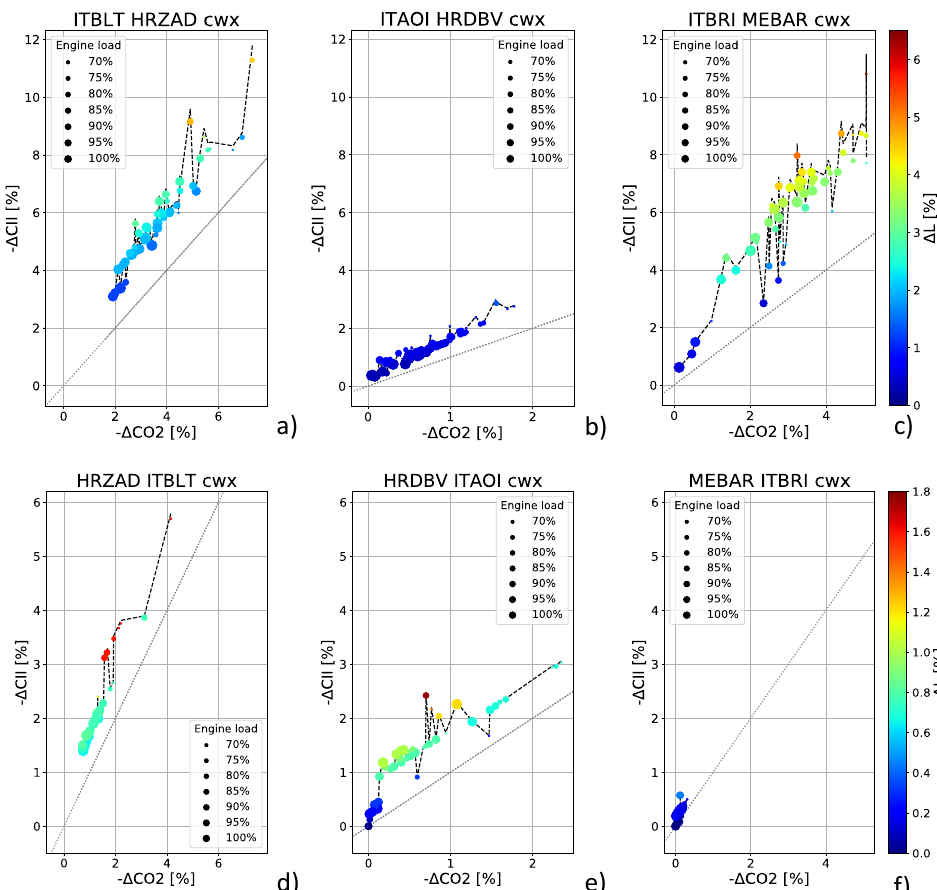
Figure 6. CII vs. CO 2 savings for the least-CO 2 routes with respect to the least-distance one, with path lengthening ∆ L as marker colour and engine load as marker size. Data refer to the same routes of Figure 5. ( a – c ) Eastbound routes; ( d – f ) Westbound routes. Both waves and sea currents considered. The black dashed line corresponds to the equality in Equation (2). For the seaport codes, see Table